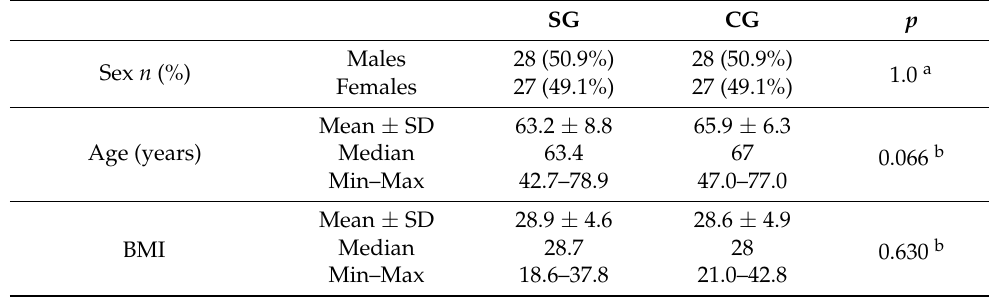
Table 1. Characteristics of the study